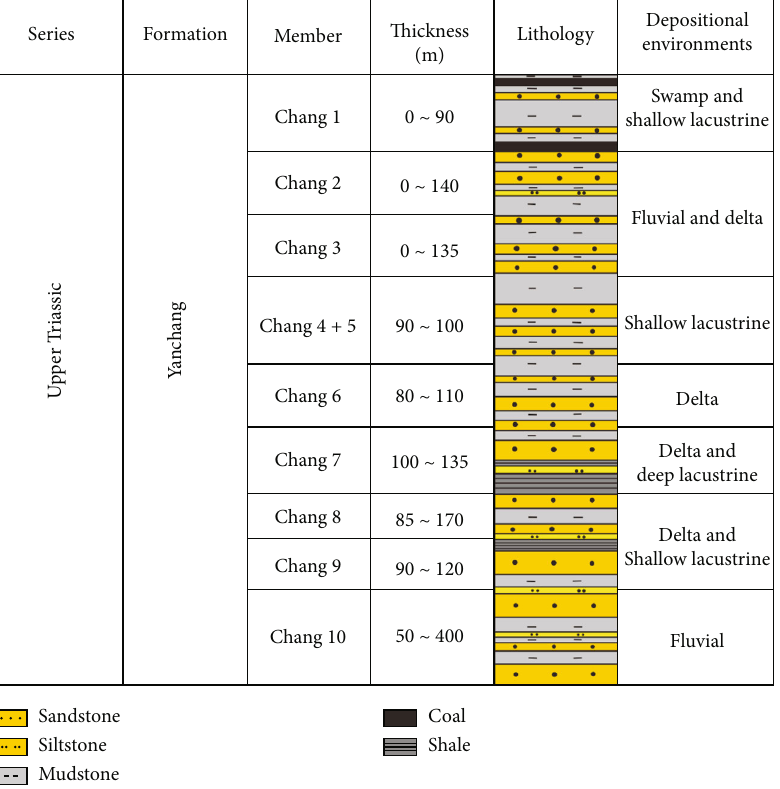
Figure 2: Stratigraphy and lithology of Upper Triassic Yanchang Formation (modi fi ed after